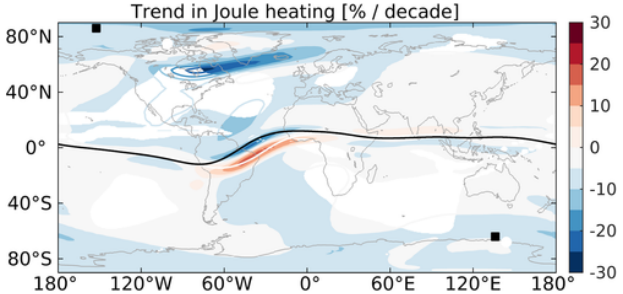
Figure 9. Trend in vertically integrated Joule heating power (%/decade) calculated with linear regression Model 3. Filled contours indicate that trends are statistically significant at the 95% confidence level, while line contours are used for non-significant trends. The location of the magnetic equator and magnetic poles in 1950 (2015) are marked with a white (black) line and white circles (black squares), respectively. (Reproduced from Cnossen [10]: Figure 4).